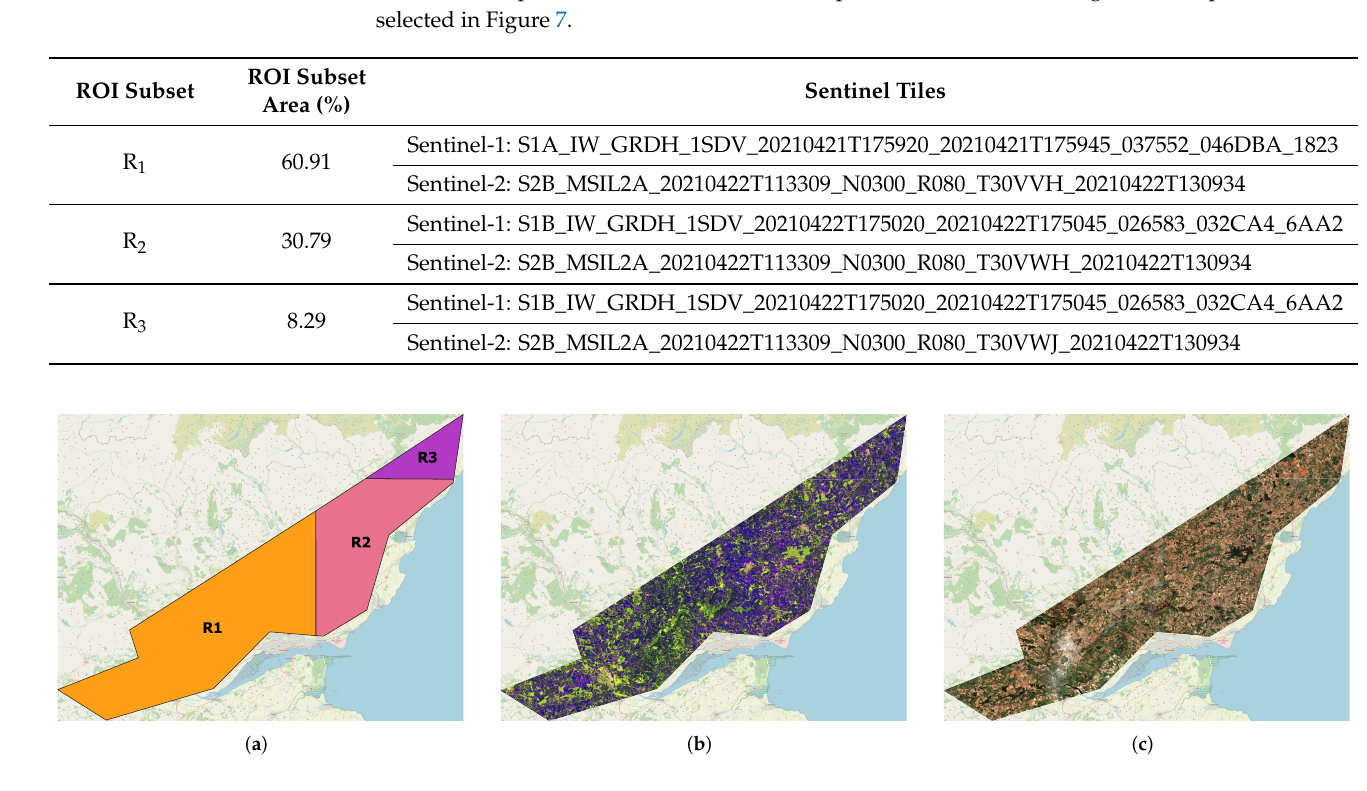
Figure 8. Example of Sentinel-1 and Sentinel-2 ARD generated with the proposed framework for the ROI selected in Figure 7: ( a ) ROI division, ( b ) Sentinel-1 mosaicking shown in false colour composite with red channel as VV, green channel as VH and blue channel as VV/VH, ( c ) Sentinel-2 RGB mosaicking. Base layer © OpenStreetMap